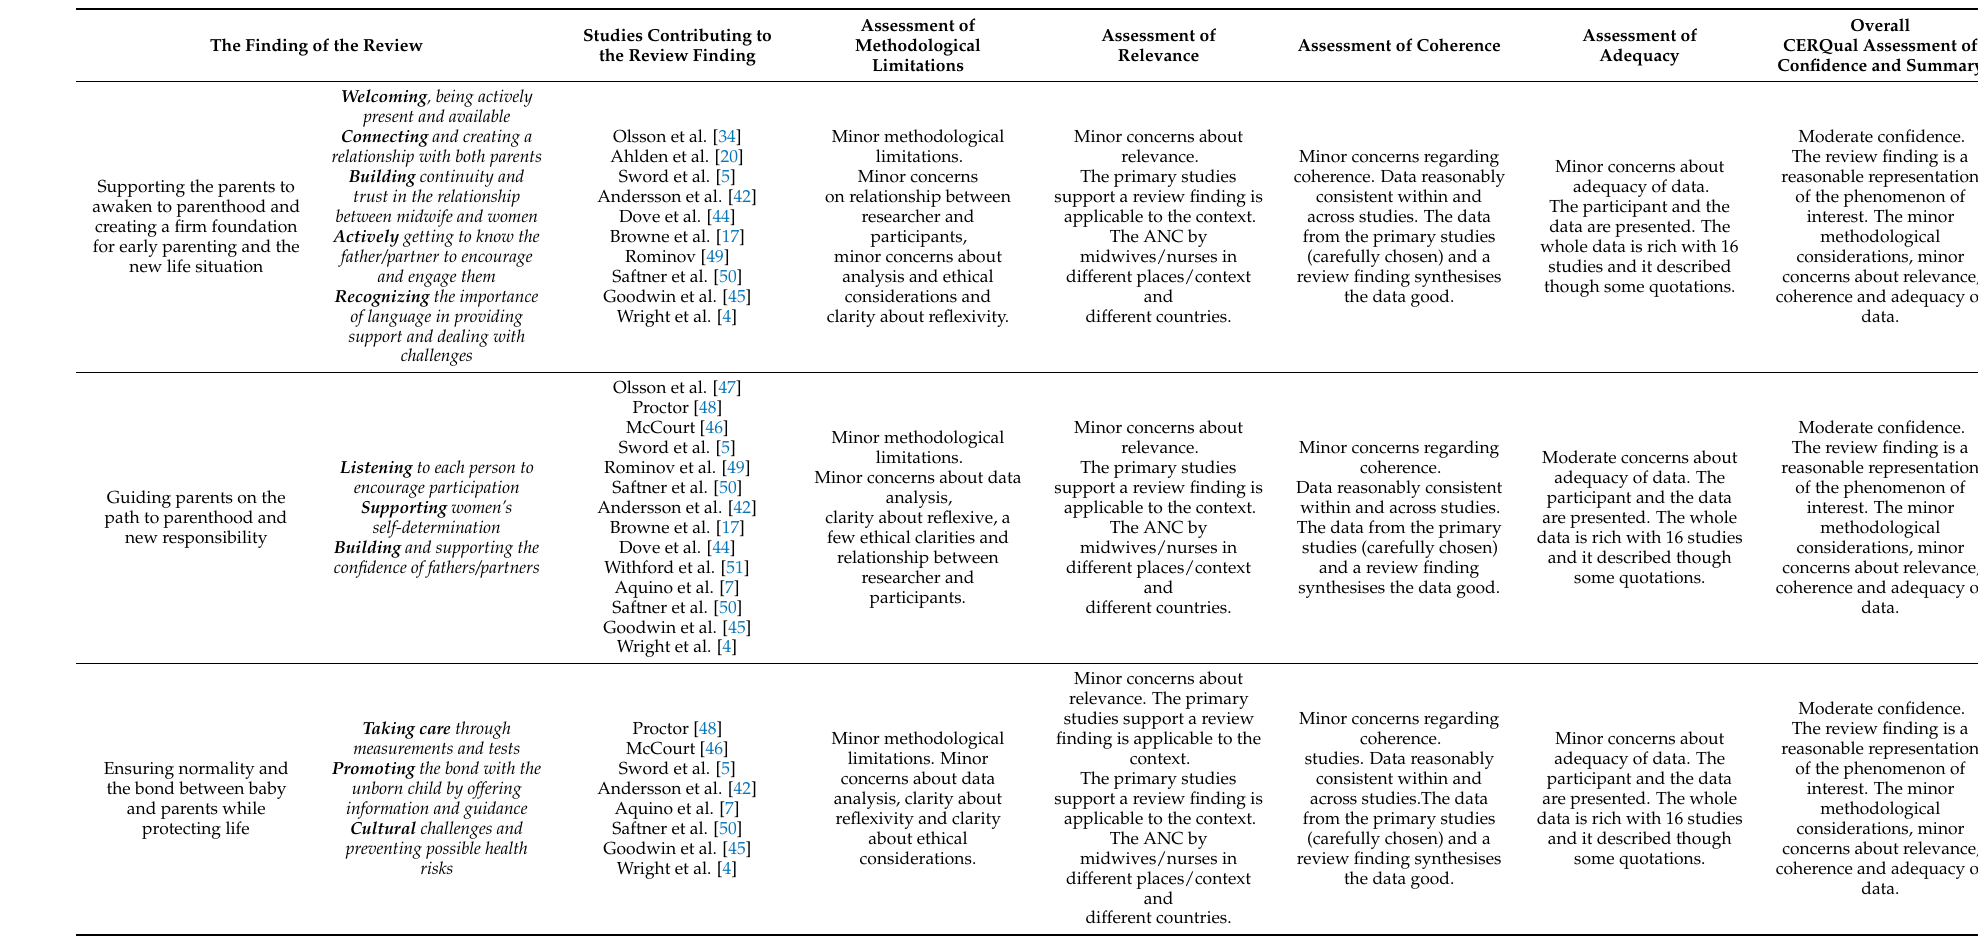
Table 6. CERQual Qualitative Evidence